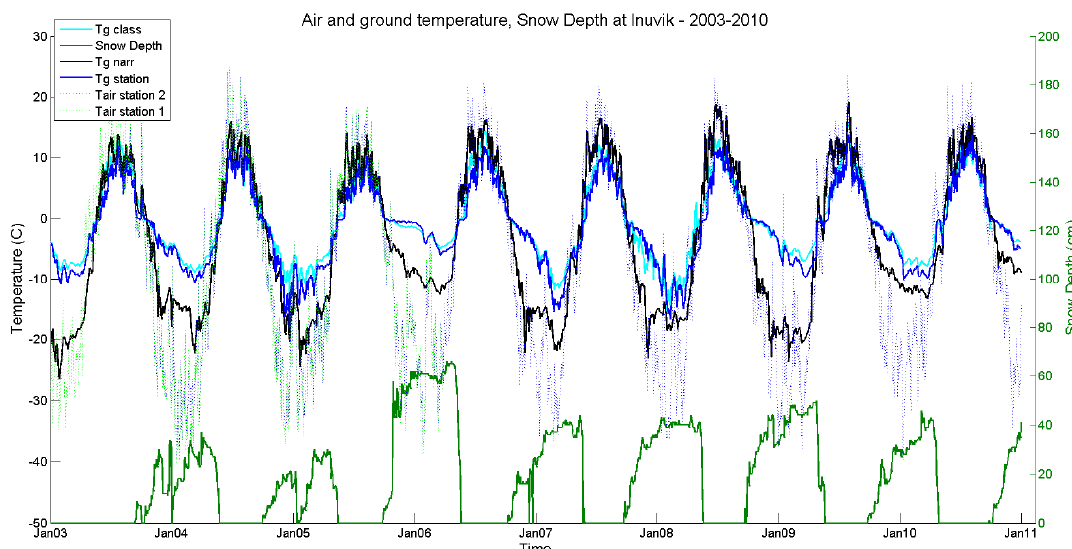
Figure 10. Optimized soil temperature evolution (CLASS AC) compared to the measured data (Station) and NARR simulations, as well as air temperature (Station) and snow depth (Station) in Inuvik during the 2003–2011 period (month/year). The T air dataset combines data from two nearby meteorological stations to yield a continuous time series (Environment Canada). The overlap period (2004–2005) shows the coherency of both time series.